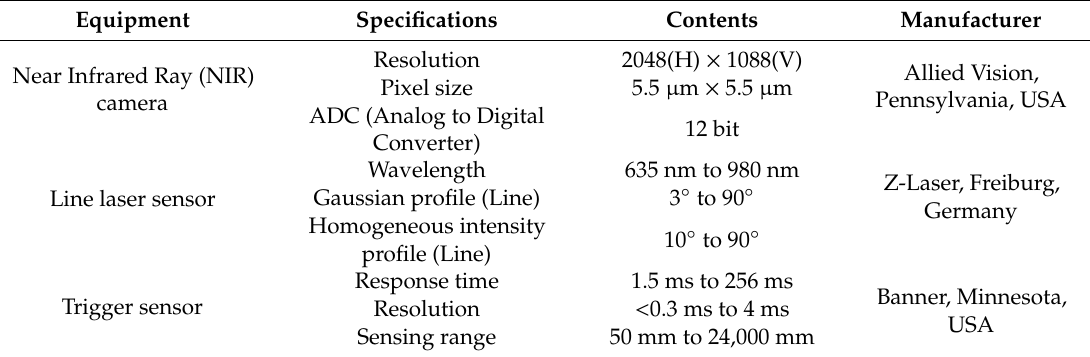
Figure 4. Configuration for the image acquisition of the proposed pantograph monitoring equipment. Table 1. Specification of the monitoring equipment.